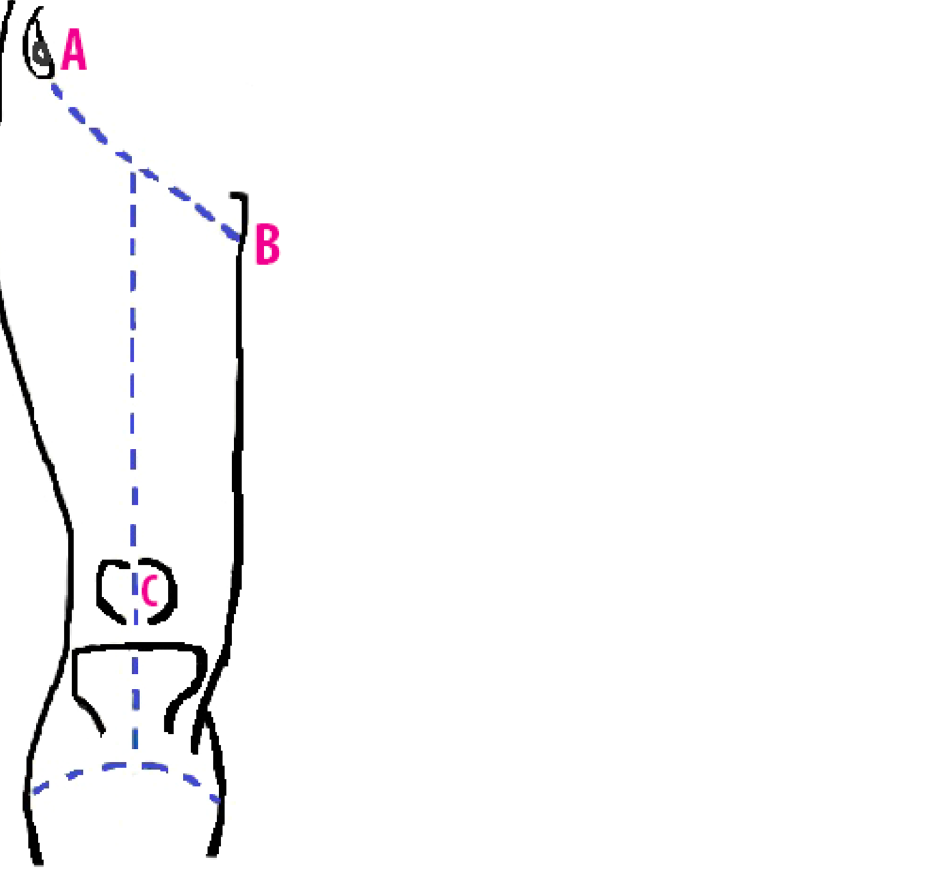
Figure 1. A horizontal incision was made on the thigh inferior and parallel to the inguinal ligament from the anterior superior iliac spine to the pubic tubercle (A–B). At the midpoint of the horizontal incision, a vertical incision was made till few centimetres below the apex of the patella